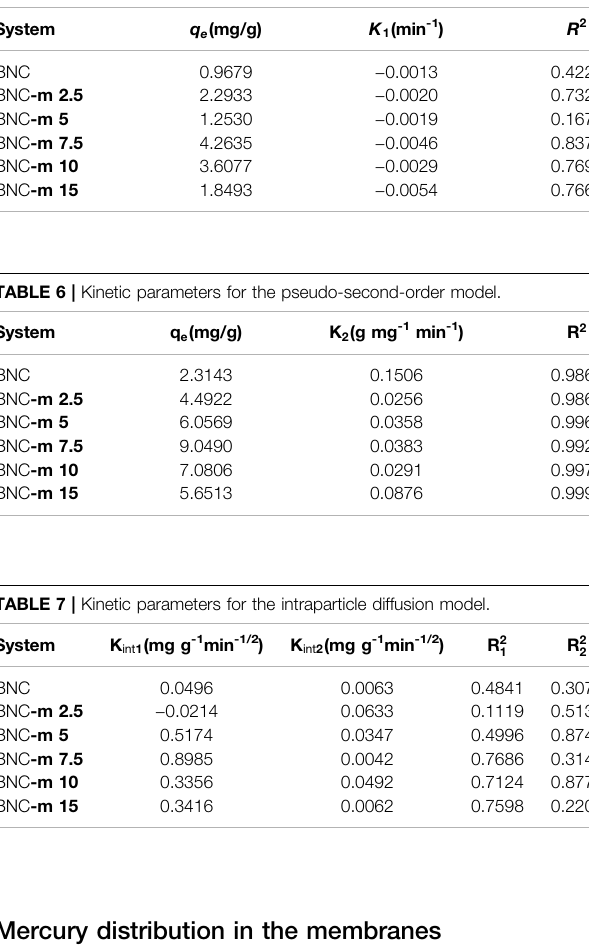
TABLE 5 | Kinetic parameters for the pseudo- fi rst-order model.